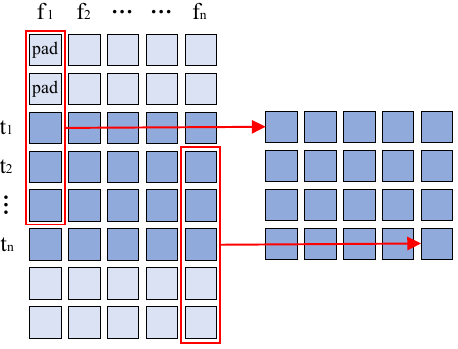
Figure 2. Pooling and convolution process of DY-CNNs.